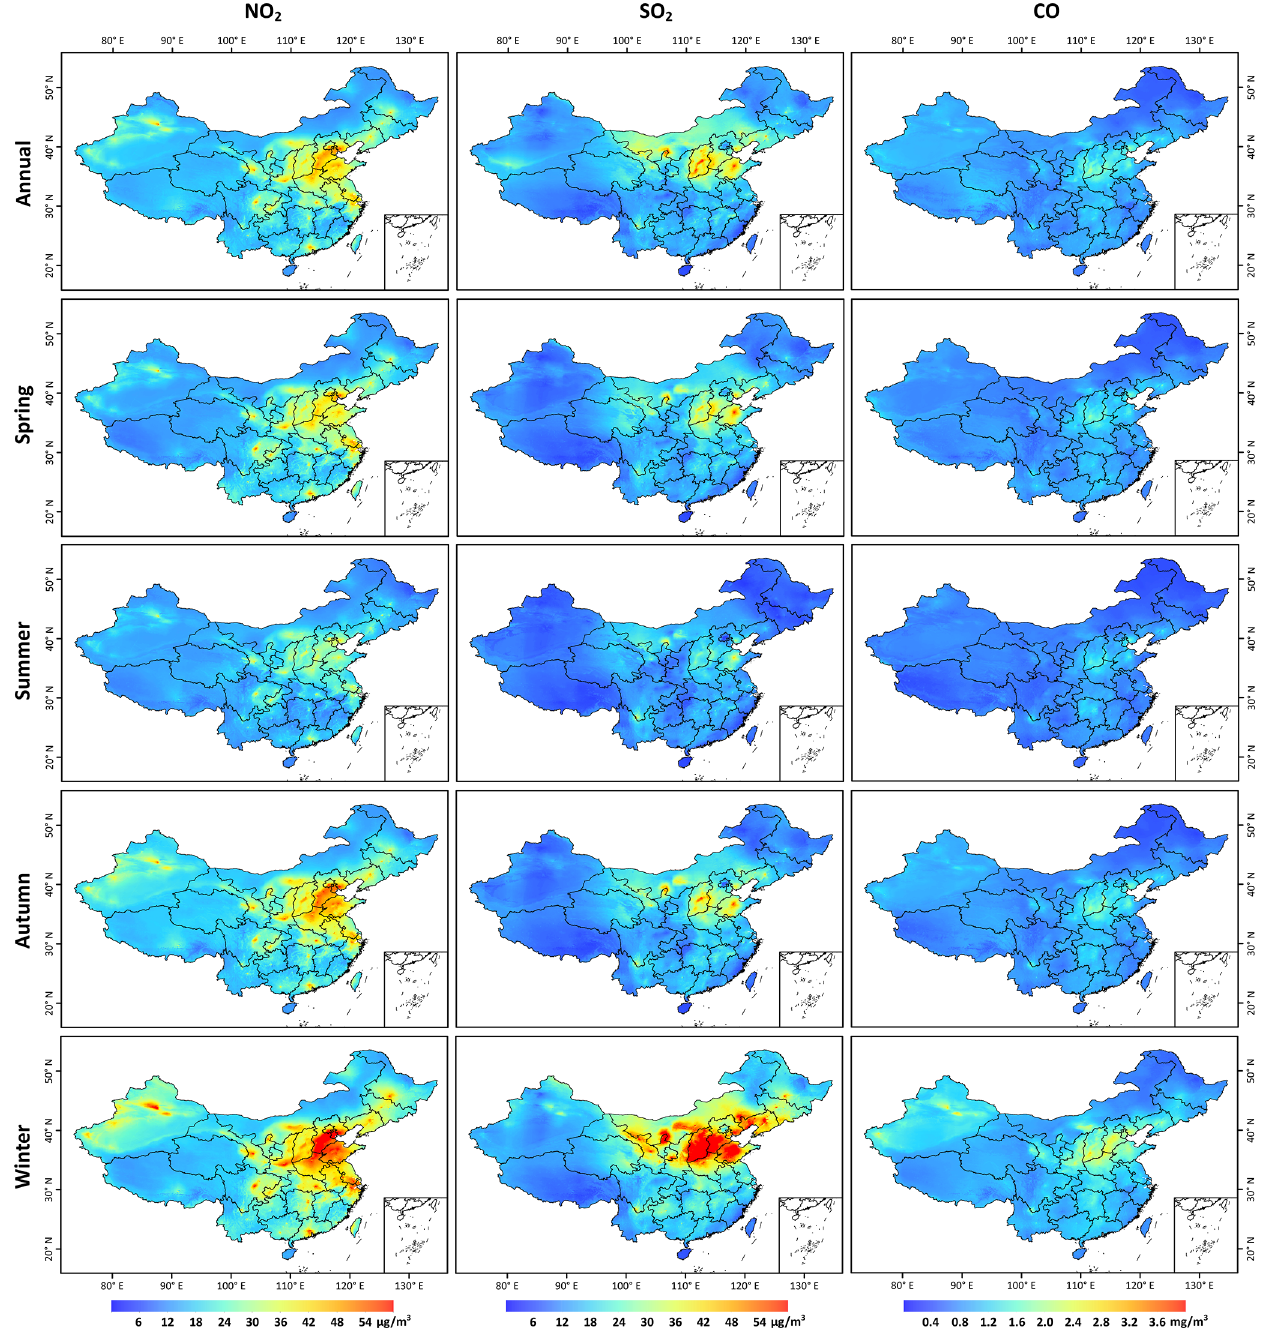
Figure 3. Annual- and seasonal-mean maps (horizontal resolution = 10km) of surface NO 2 (µgm − 3 ), SO 2 (µgm − 3 ), and CO (mgm − 3 ) averaged over the period 2013–2020 in